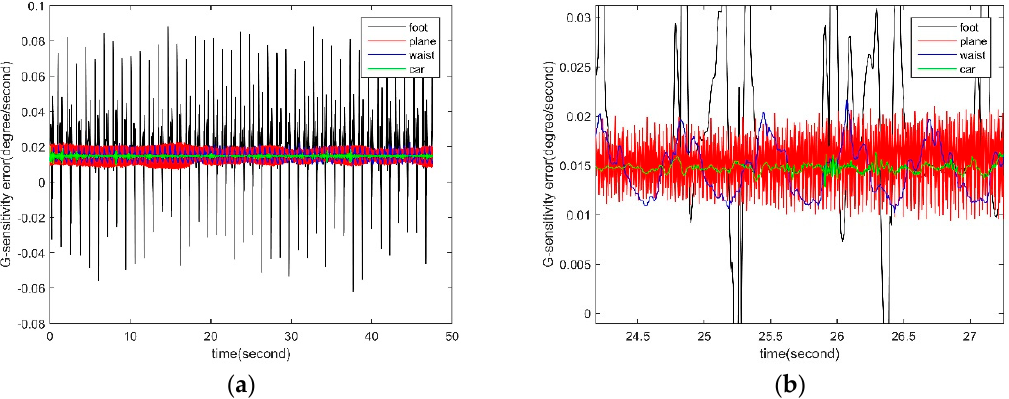
Figure A4. The G-sensitivity error corresponding to each sampling point. ( a ) The G-sensitivity error corresponding to each sampling point from four different carriers for plane, car, foot and waist; ( b ) Partial enlarged detail for ( a